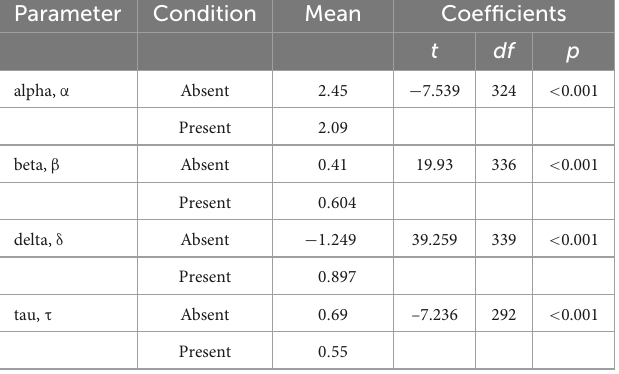
TABLE 5 Results of cognitive parameter t -tests for Visual Search conditions.